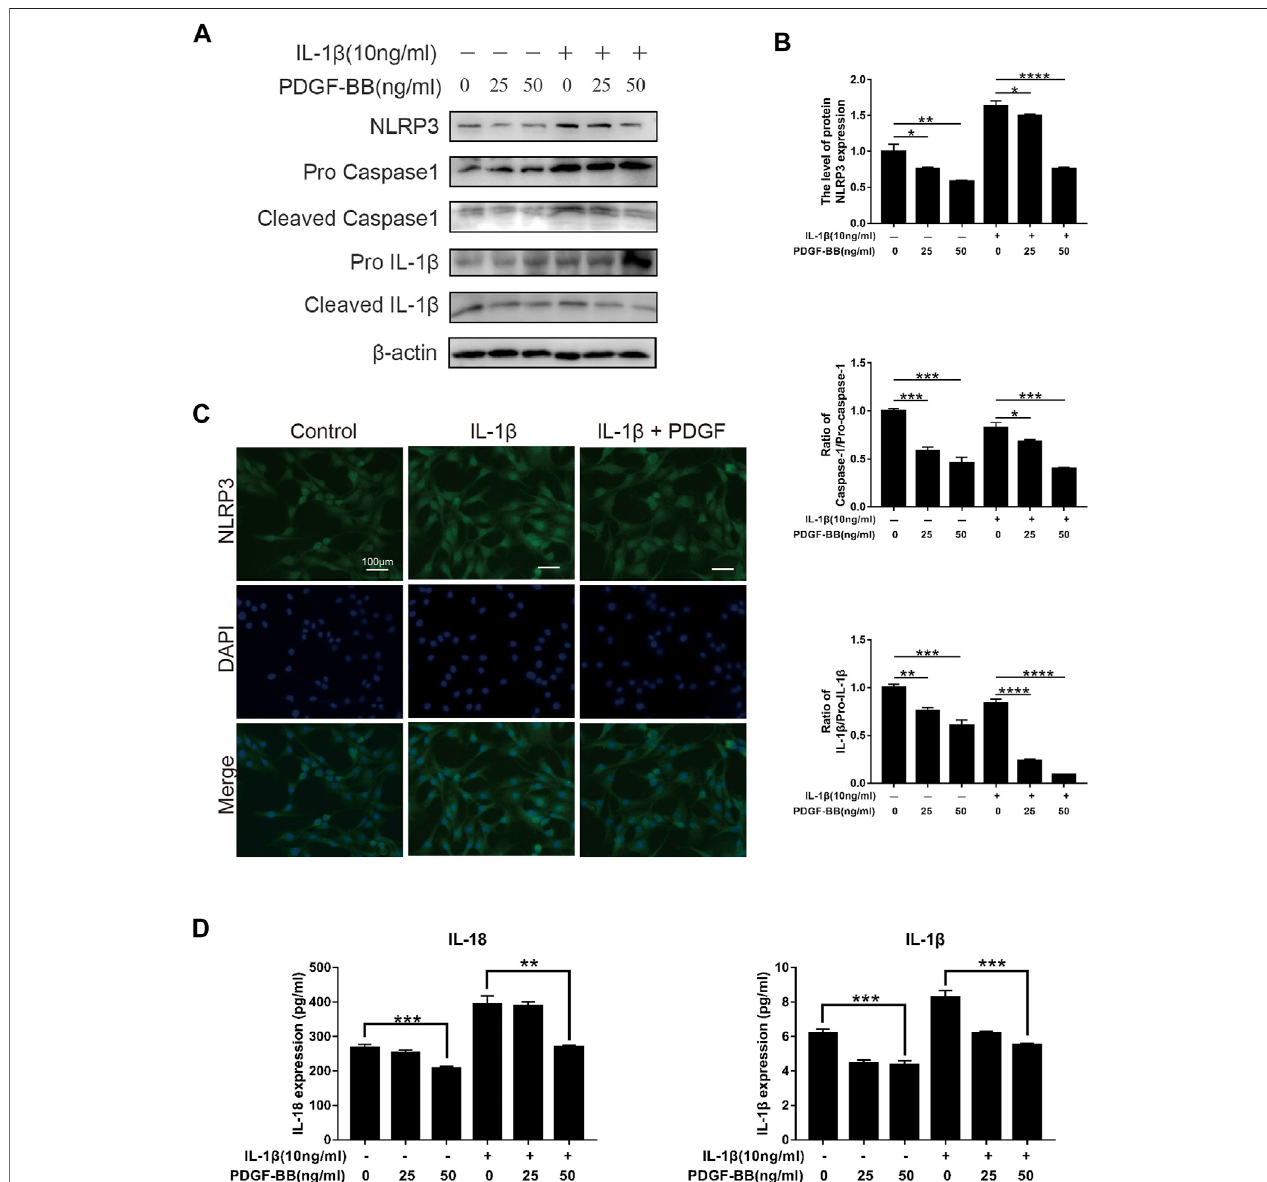
FIGURE 6 | Effects of PDGF-BB on the Pyroptosis pathway in IL-1 β -treated NPCs. (A,B) Western blot showed that PDGF-BB inhibits the expression of NLRP3 and reduces the ratios of cleaved IL-1 β to pro-IL-1 β , and cleaved caspase-1 to pro-caspase-1. All NP cells were treated with or without IL-1 β (10 ng/ml) and PDGF-BB for 48 h. The results were quanti fi ed using ImageJ software. (C) Representative images of NP cells treated with IL-1 β and PDGF-BB for 48 h. Scale bar, 100 μ m. (D) ELISA showed that PDGF-BB inhibits the expression of IL-1 β and IL-18. Data are presented as the mean ± D. n (cid:1) 3. Signi fi cant differences between groups are indicated as **** p < 0.0001, *** p < 0.001, ** p < 0.01, * p <